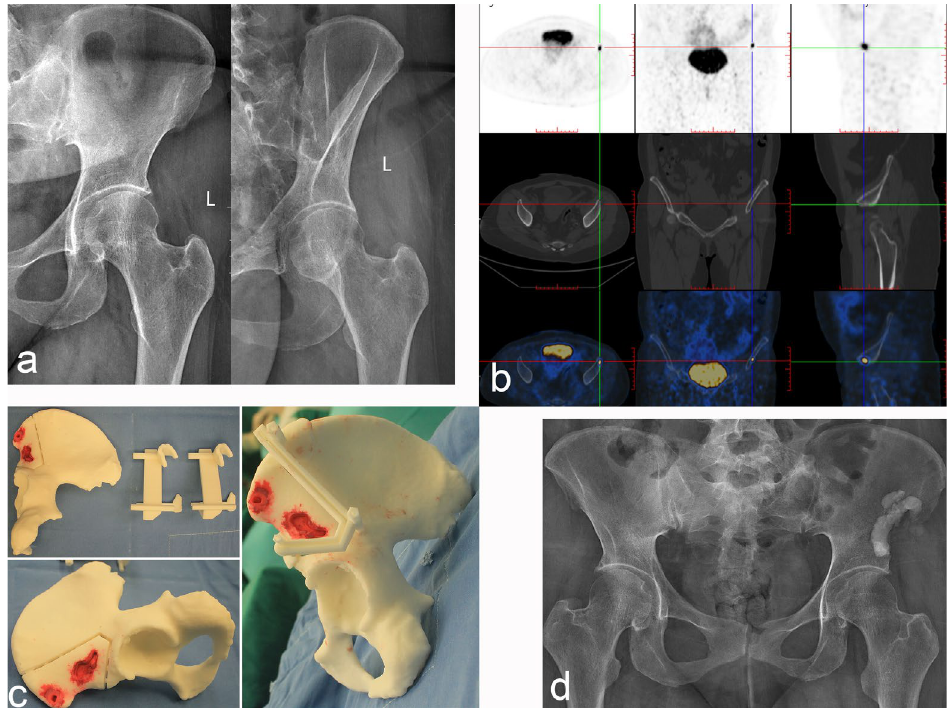
Figure 5. Case 2: PMT of the left iliac crest was treated with radical resection and cement filling. ( a ) Anteroposterior and oblique X-rays of the pelvis. ( b ) Tc99m-octreotide PET/CT scan accurately located the lesions and showed abnormal concentration. ( c ) The 3D printing technology reproduces the lesion and designs the osteotomy guide plate. ( d ) Postoperative anteroposterior X-ray of the pelvis.